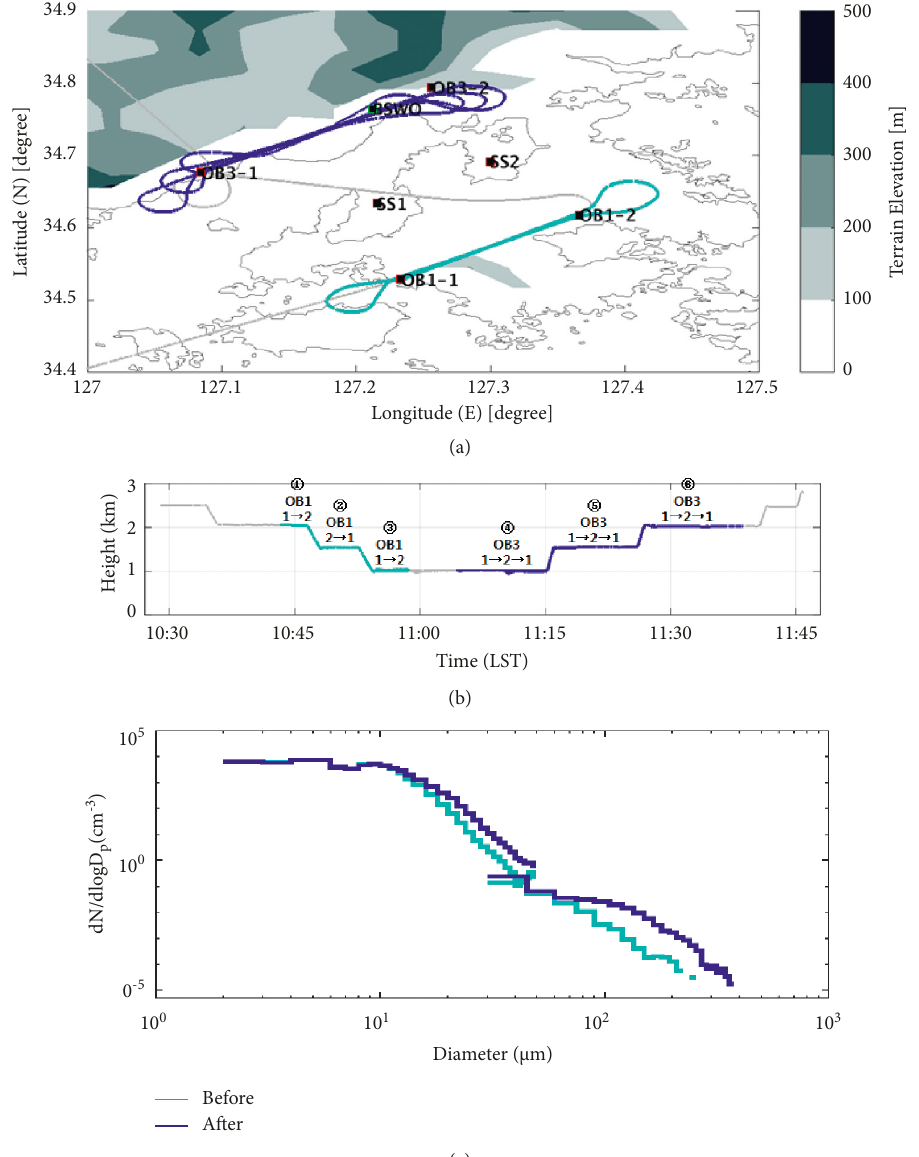
Figure 6: (a) Flight path map, (b) time series of flight height from 1030 to 1145 LST, and (c) average cloud size distribution at 1 km height before (cyan) and after seeding (blue) on April 25, 2019.